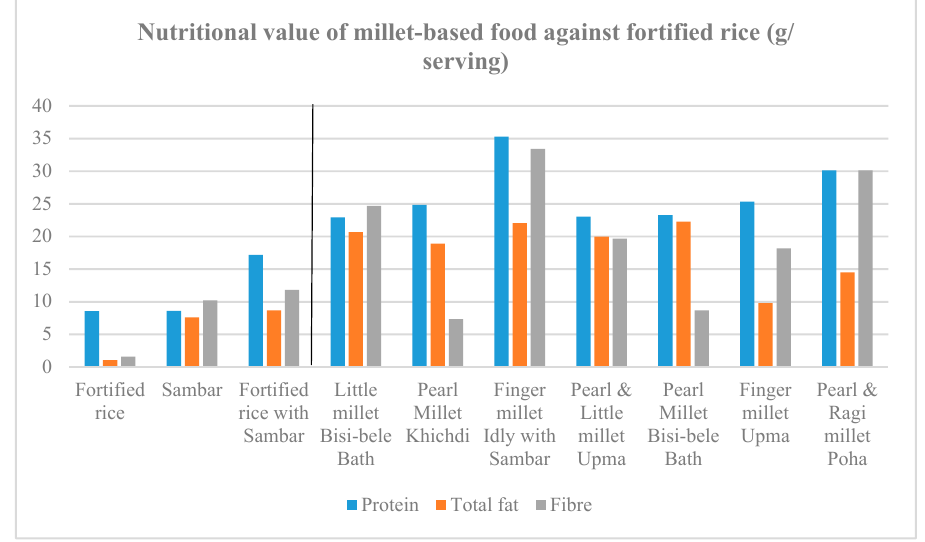
Figure 2. Protein, unsaturated fat and fibre content in millet-based meals in comparison with a fortified rice-based meal.